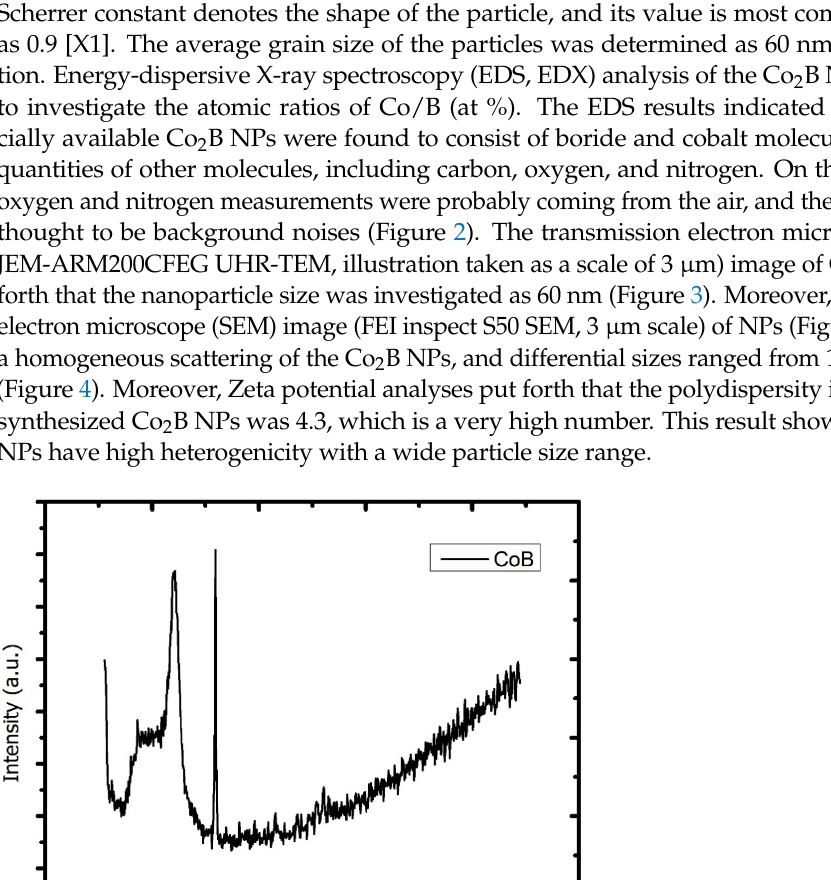
Figure 2. Energy ‐ dispersive X ‐ ray spectroscopy (EDS, EDX) results of Co2B NPs show the atomic ratios of Co/B (at %).